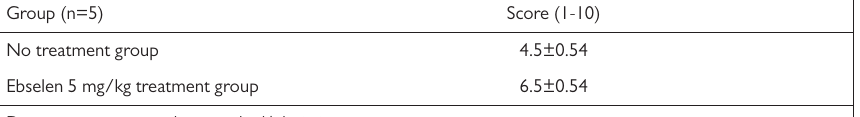
Table 3. Histological fracture healing scores